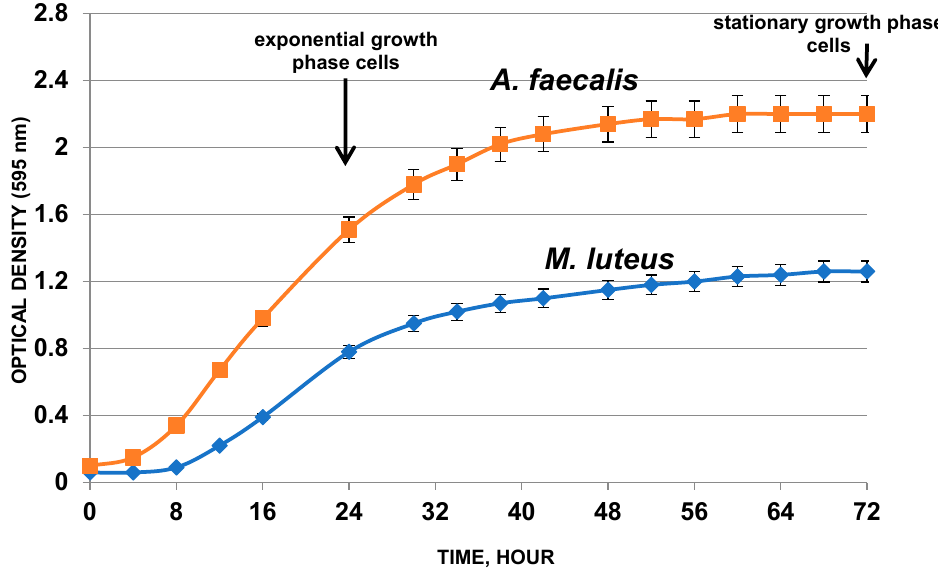
Figure 1. Growth curves of control populations of A. faecalis and M. luteus